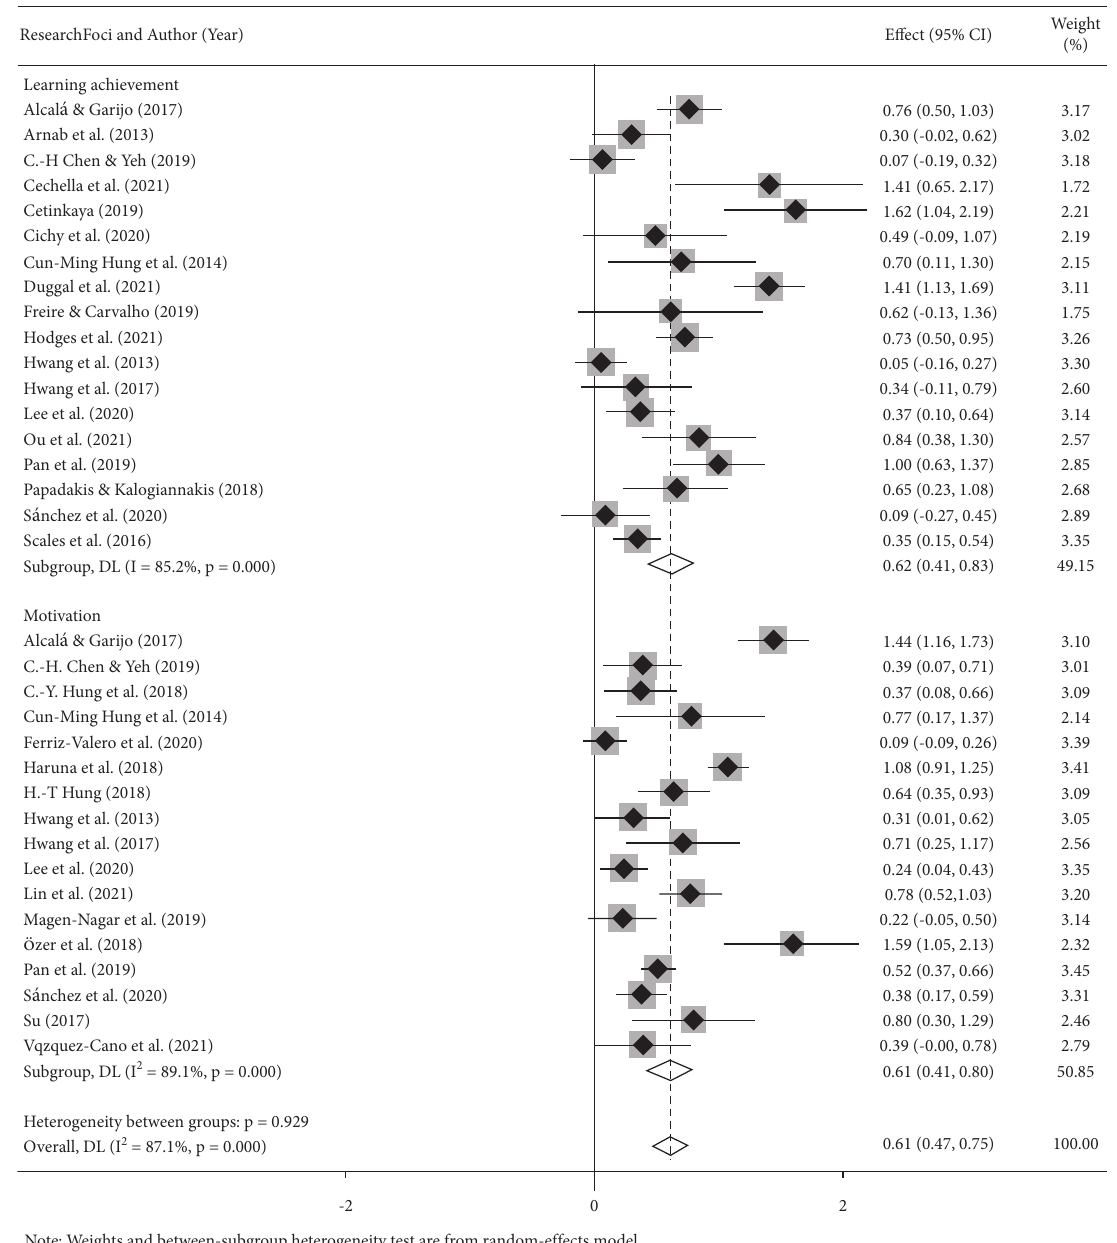
Figure 6: Forest plots presenting the effects of gamification platforms including Classcraft on learning achievement and motivation contributing to optimal gamification learning